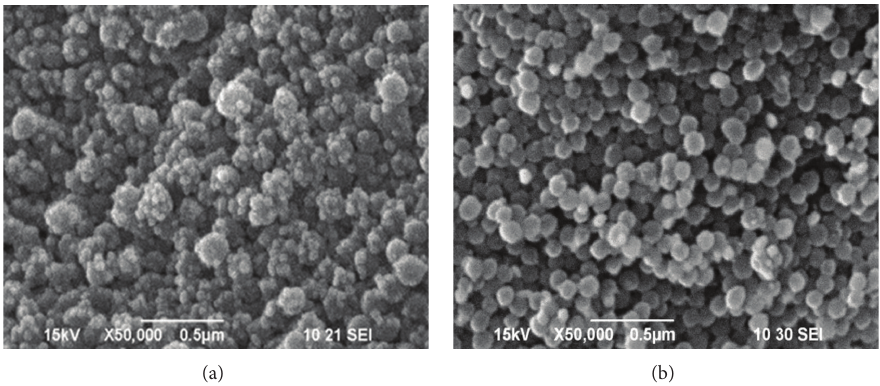
Figure 2: SEM images of the silica containing immobilized: nanosilver (a) and nanocopper (b).